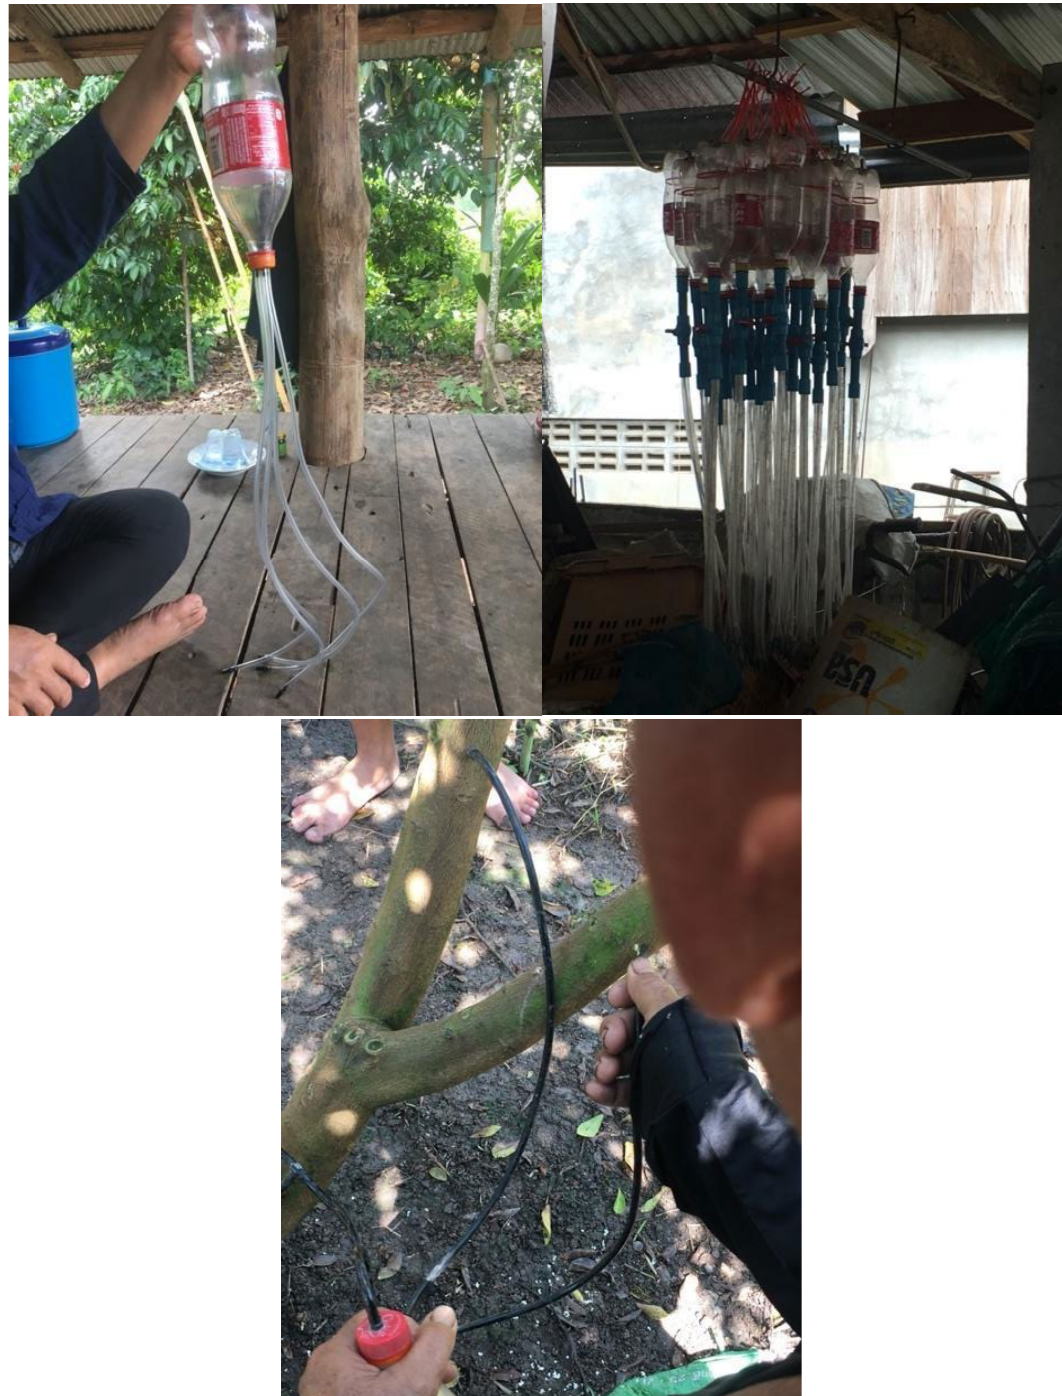
Figure 2 . Left to right: Plastic soda bottles adapted for use as antibiotic infusion kit, with four tubes to connect to the mandarin tree; PVC pipes and valves are added to the bottle to control the solution; an electric drill is used to make holes on citrus tree trunks for tube insertion. Images by author Thitima